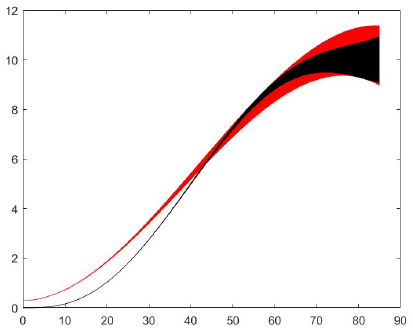
Figure 9. Example showing 10,000 curves of ϕ 1 and ϕ 2 with 0.9883 ≤ a ≤